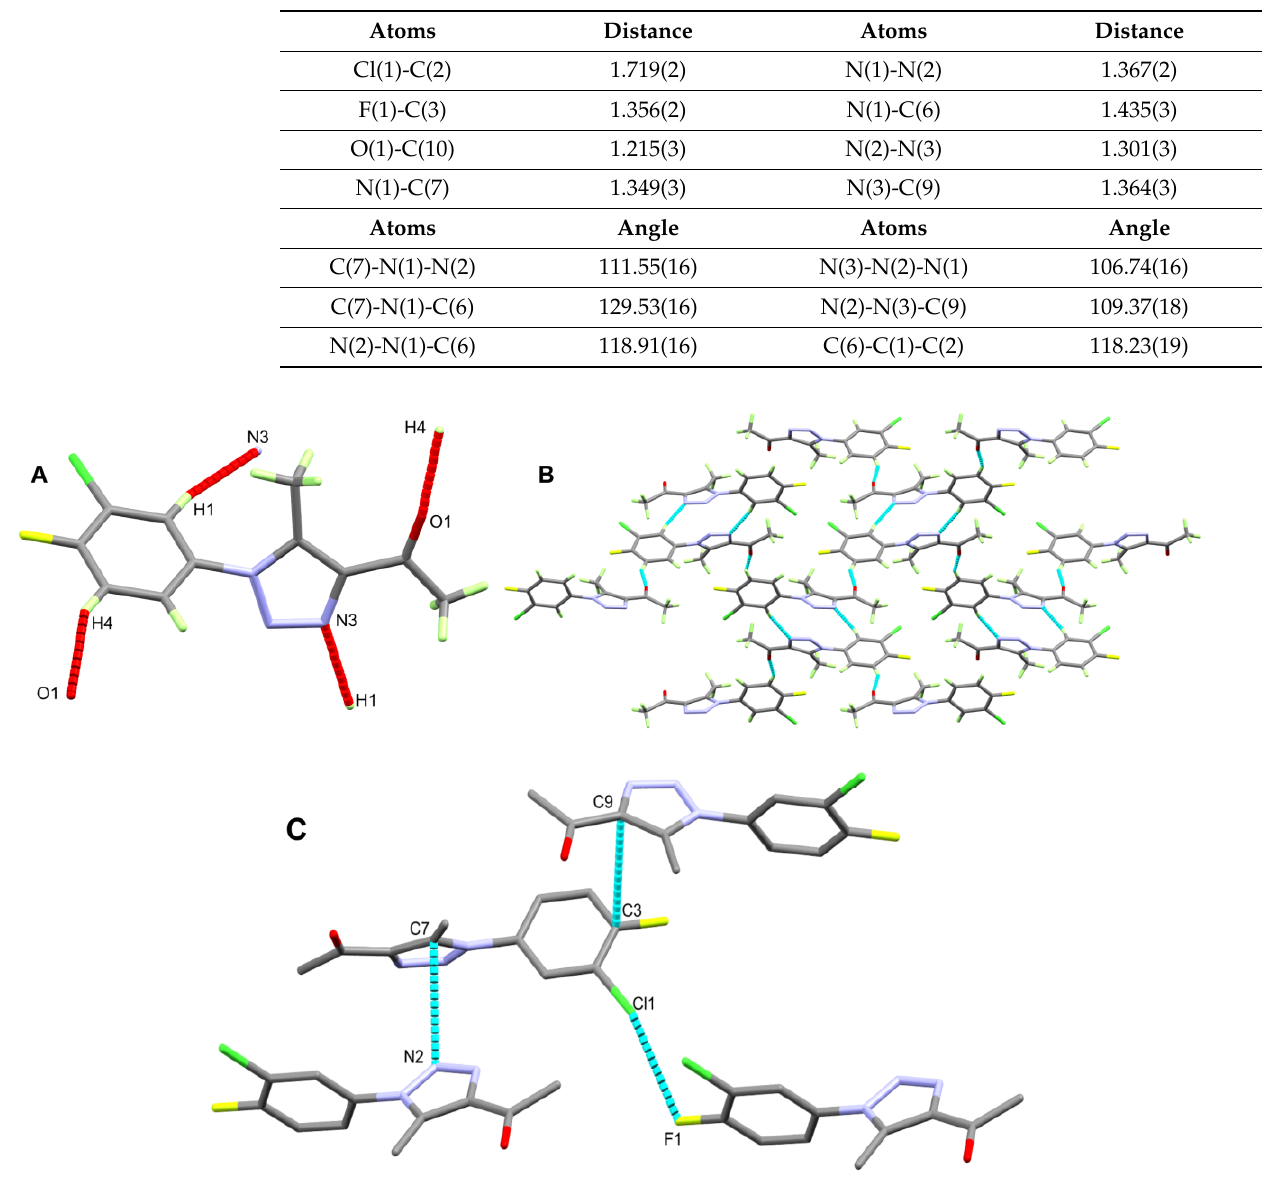
Table 2. Selected bond lengths [Å] and angles [ ◦ ] for triazole ligand 3 .